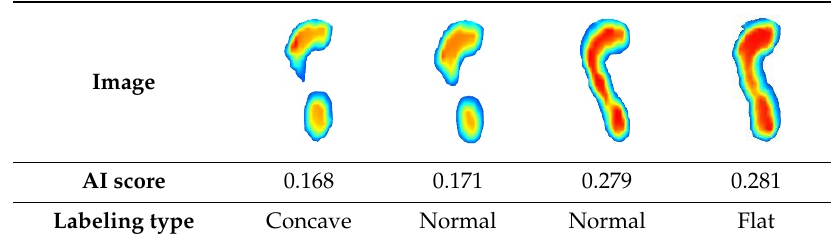
Table 5: Image of arch index score’s labeling boundary.